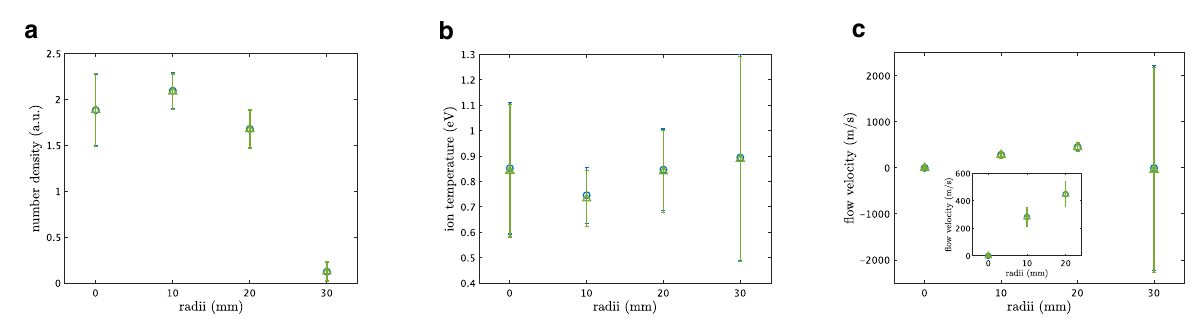
Figure 5. Bayesian model selection for LIF spectrum at each radius. ( a – c ) LIF spectra (black dots) and their reproduction (red dashed line) at r = 0 mm, 20 mm, and r = 30 mm. The reproduction curves are best-fit solutions assuming function III for r = 0 mm and 20 mm, and function I for r = 30 mm. ( d – f ) Posterior probability against the form of ion velocity distribution function under LIF spectrum at each radius